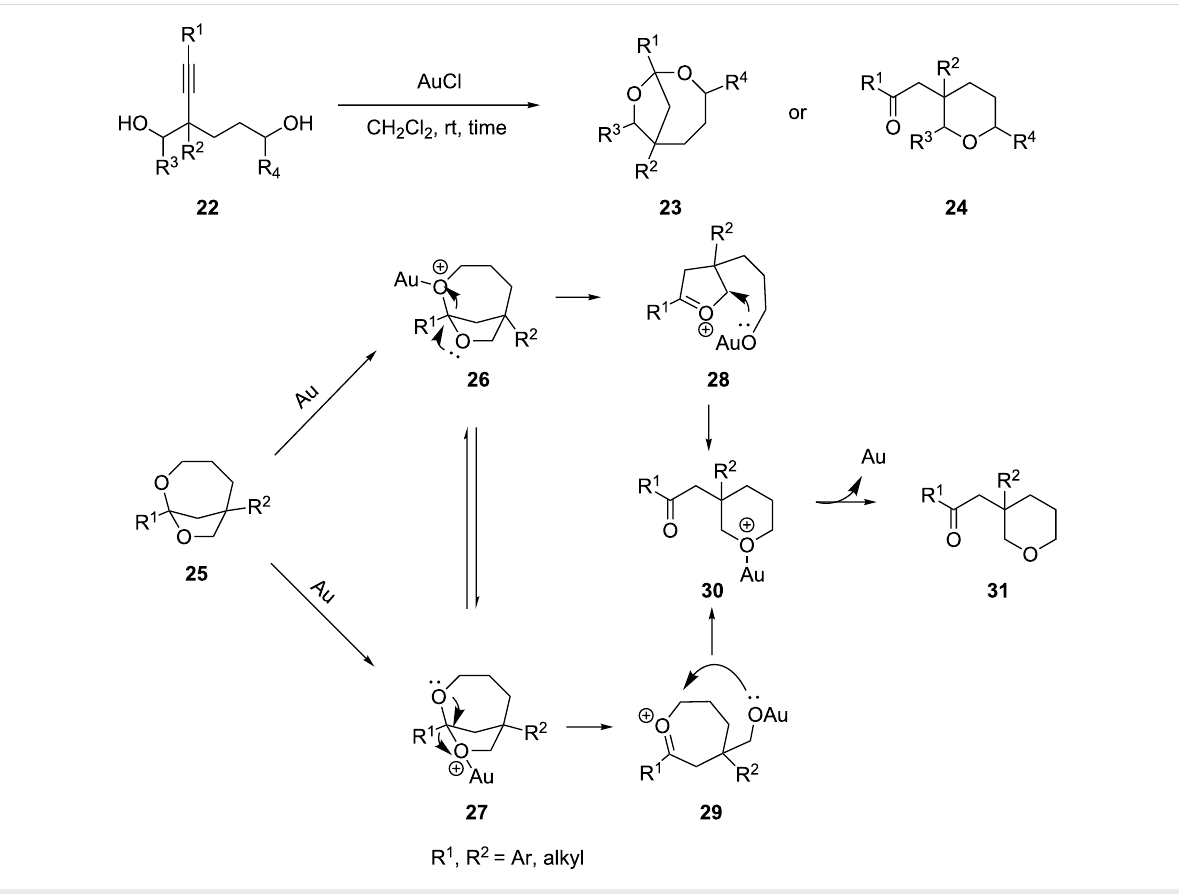
Scheme 5: Gold(I) chloride catalyzed cycloisomerization of 2-alkynyl-1,5-diols.